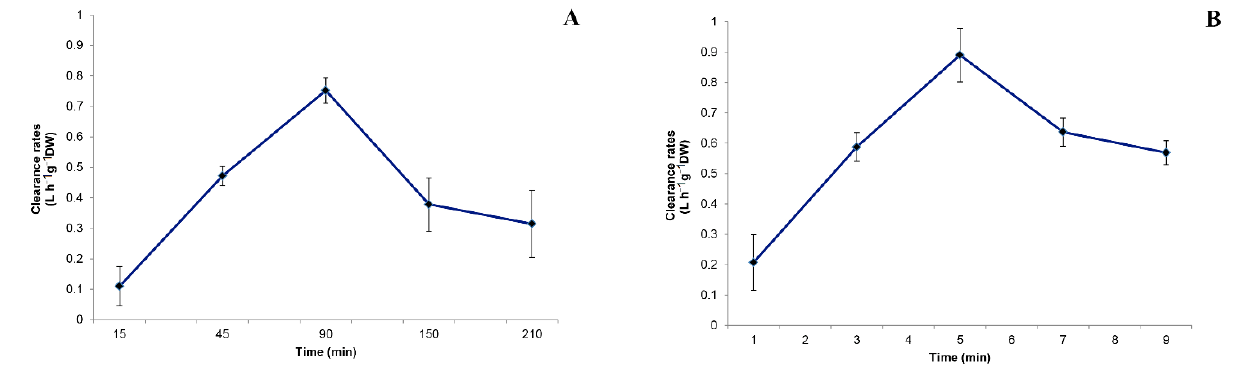
Figure 4. Clearance rates (C) calculated within each sampling time for ( A ) Sabella spallanzanii and ( B ) Branchiomma luctuosum .